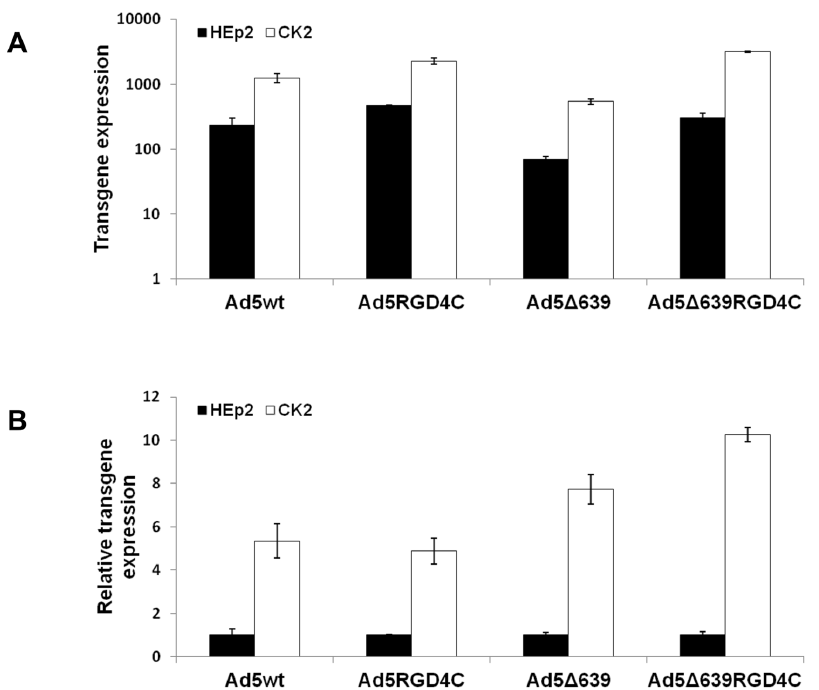
Figure 2. Ad5-mediated transgene expression in cisplatin-resistant CK2 cells is higher than in parental HEp2 cell line. Cells were plated in 96-well plates and, 24 hours later, infected for 1 hour at 37 u C with two-fold serial dilutions of Ad5s. Twenty-four hours after infection, cells were stained for b -galactosidase expression. A similar difference was observed over a wide range of dilutions, from 2 6 10 4 to 5000 pp/cell; however, only the transgene expression obtained with a MOI of 10 4 pp/cell is presented. (A). Transgene expression in HEp2 and CK2 cells after transduction with Ad5wt, Ad5RGD4C, Ad5 D 639 and Ad5 D 639RGD4C. (B). Data shown in (A) represented as relative to HEp2 cells. The results presented are representative of three independent experiments with similar results 6 standard